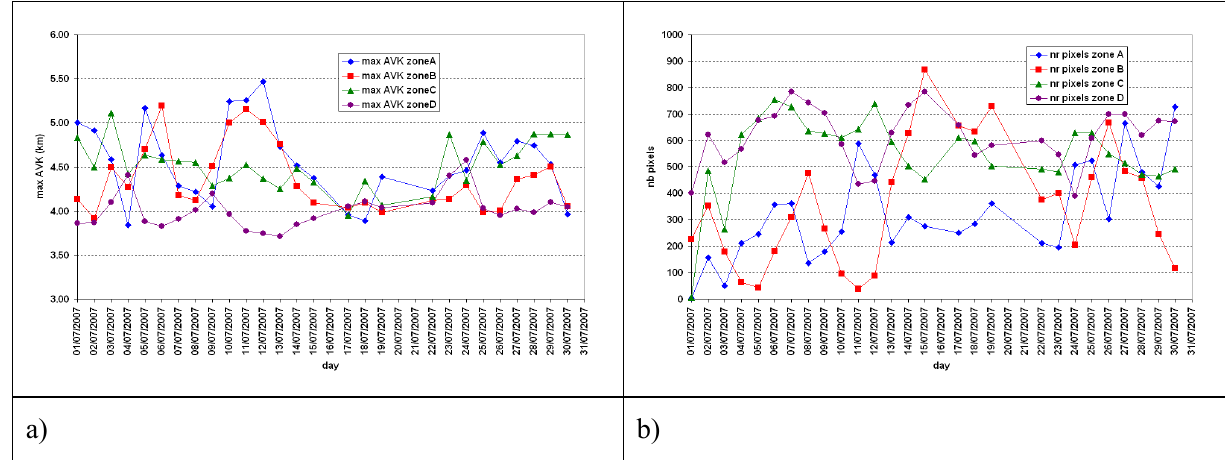
Fig. 3. (a) Day to day variation of the altitude of the maximum AVK (averaging kernel) averaged over the four quadrants of the domain, for July 2007; (b) day to day variation of the number of pixels used in assimilation for the four zones (blue for zone A, red for zone B, green for zone C and violet for zone